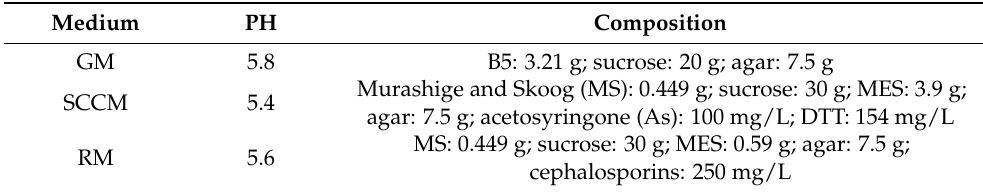
Table 2. Media for soybean cotyledon node transformation [26,27].